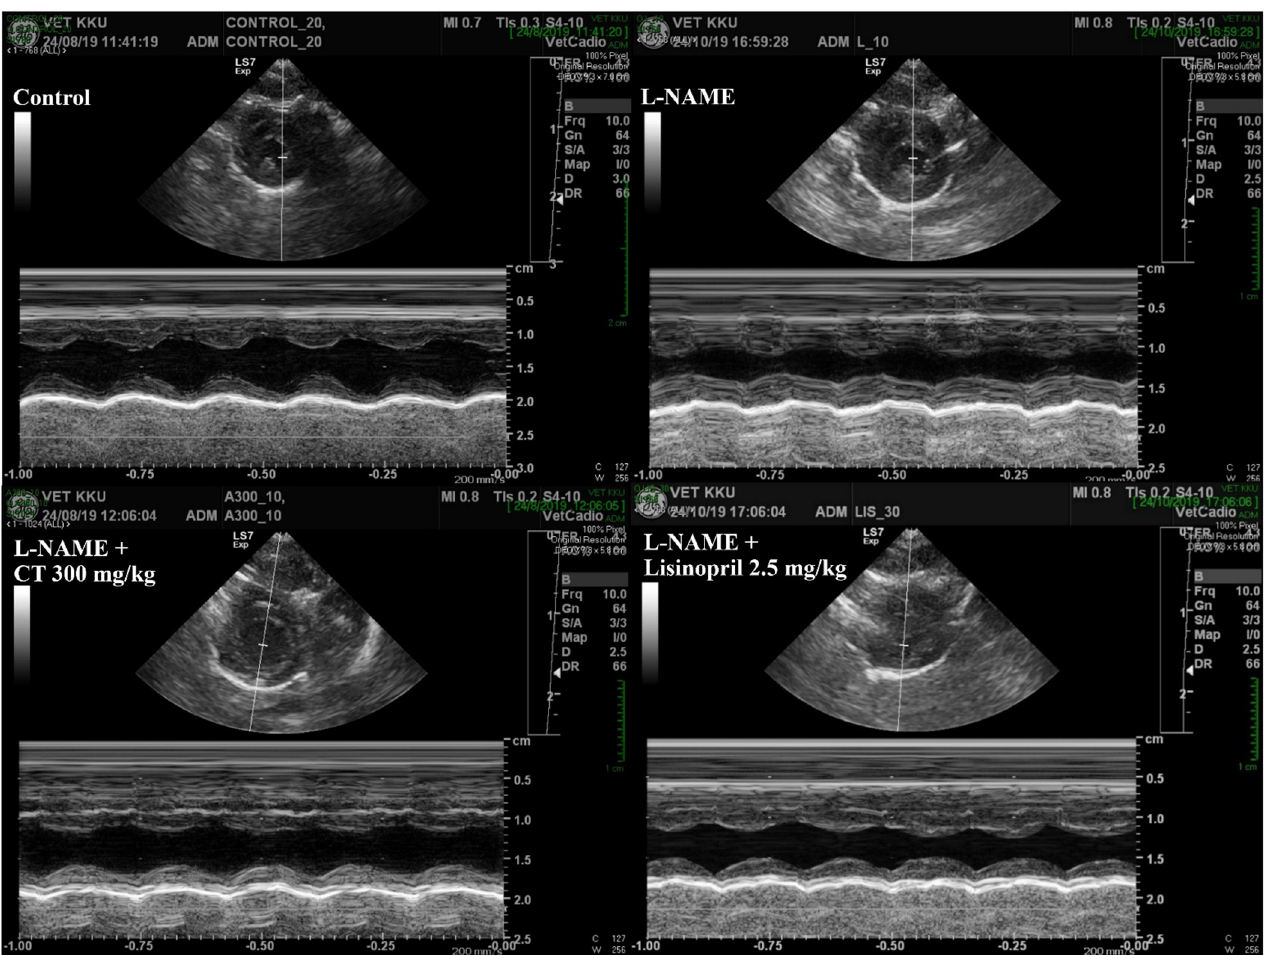
Figure 4. Representative tracings of transthoracic echocardiographs in all groups of rats. CT: Clitoria ternatea Linn. extract. Table 3. Effects of CT extract and lisinopril on ventricular dysfunction in all groups of the experiment. Parameters Control